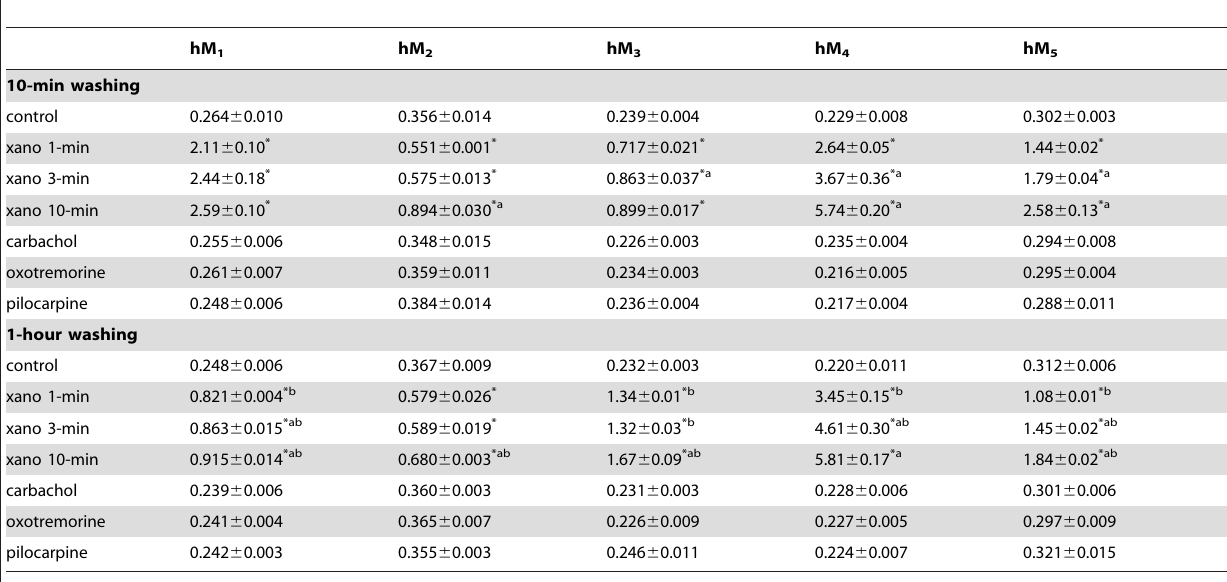
Table 3. Equilibrium dissociation constants (K D ) of [ 3 H]NMS binding to the membranes of the cells treated with xanomeline, carbachol, oxotremorine or pilocarpine is expressed in nM.